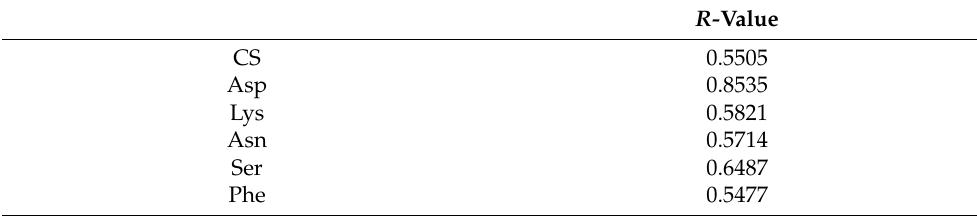
Table 3. R -values of the powdered irradiated precipitates formed after 60 min reaction time (150 min in case of Ser) in control system (CS) and in the presence of 5 mmol dm − 3 aspartic acid (Asp), lysine (Lys), asparagine (Asn), serine (Ser) and phenylalanine (Phe). c (CaCl 2 · 2H 2 O) = c (Na 2 HPO 4 ) = magnetic stirring.